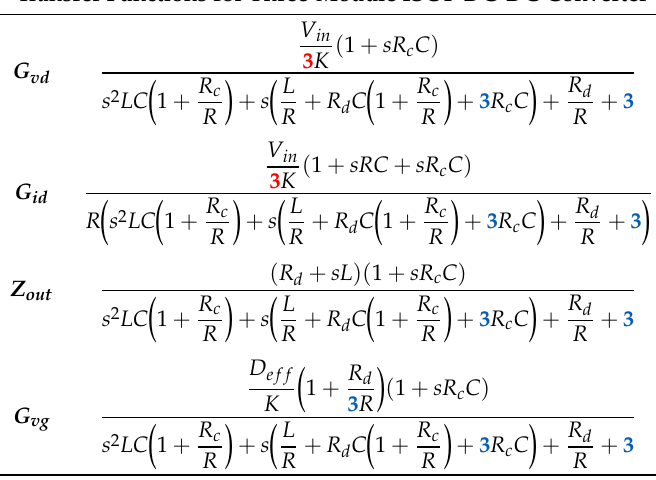
Table 5. Generalized model verification with the three-module ISOP power converter. Transfer Functions for Three-Module ISOP DC-DC Converter